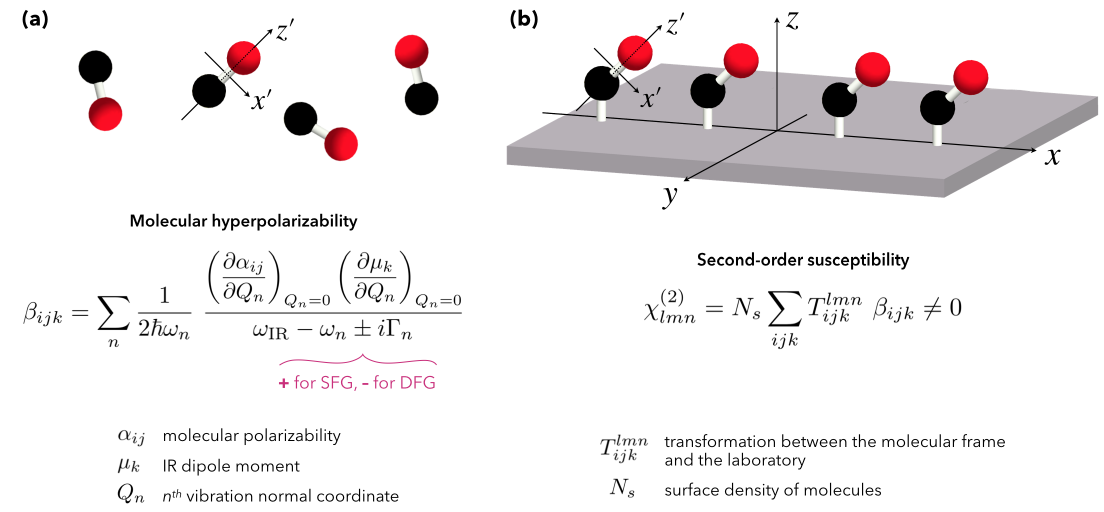
Figure 3. Microscopic view of the hyperpolarizability β of a carbon monoxide molecule ( a ) and macroscopic view of the non-linear second-order susceptibility χ ( 2 ) of a carbon monoxide layer adsorbed on a platinum substrate ( b ). β and χ ( 2 ) are third-rank tensors with 27 components that can be probed by SFG spectroscopy as a function of the SFG, Visible and IR laser beams polarization: p or s as defined in Figure 2. These non-linear physical values are related through a coordinate transformation T from the molecular frame to the laboratory